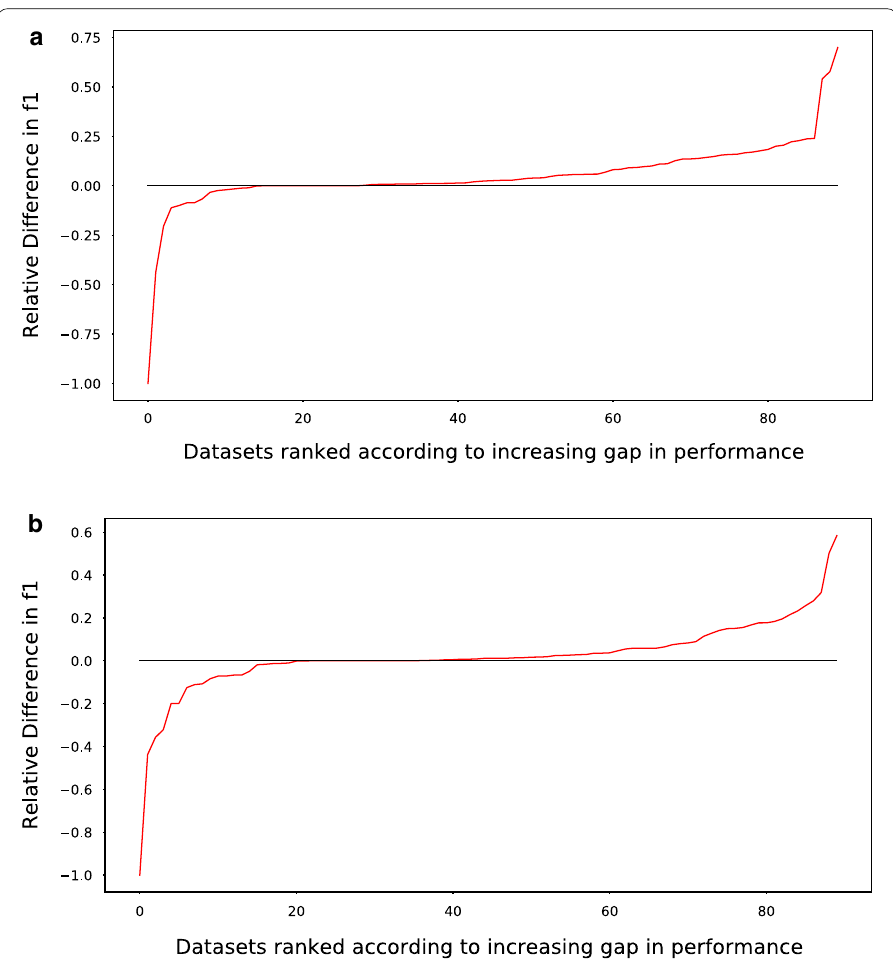
Fig. 4 Comparing black box and white box models. For both plots, the datasets are ordered according to the gap in f1-score between the best black box and the best native (left figure) or surrogate (right) white box model (right). The y-axis measures the relative difference in the f1-score, defined as the ratio of the difference between the black and white box f1-scores divided by that of the best